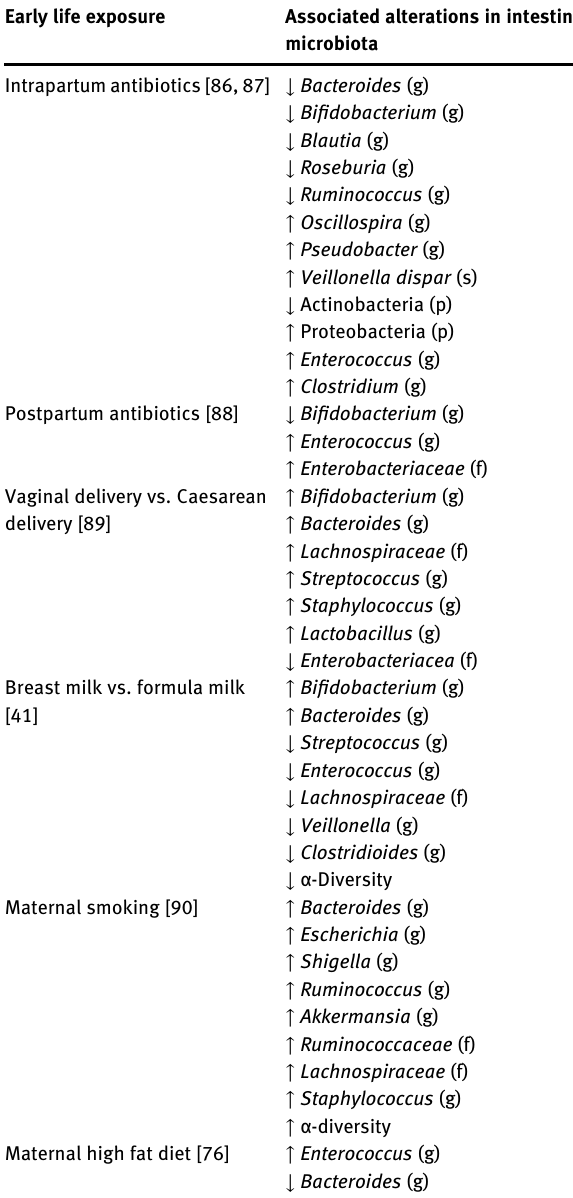
Table  : Early life exposures and impact on